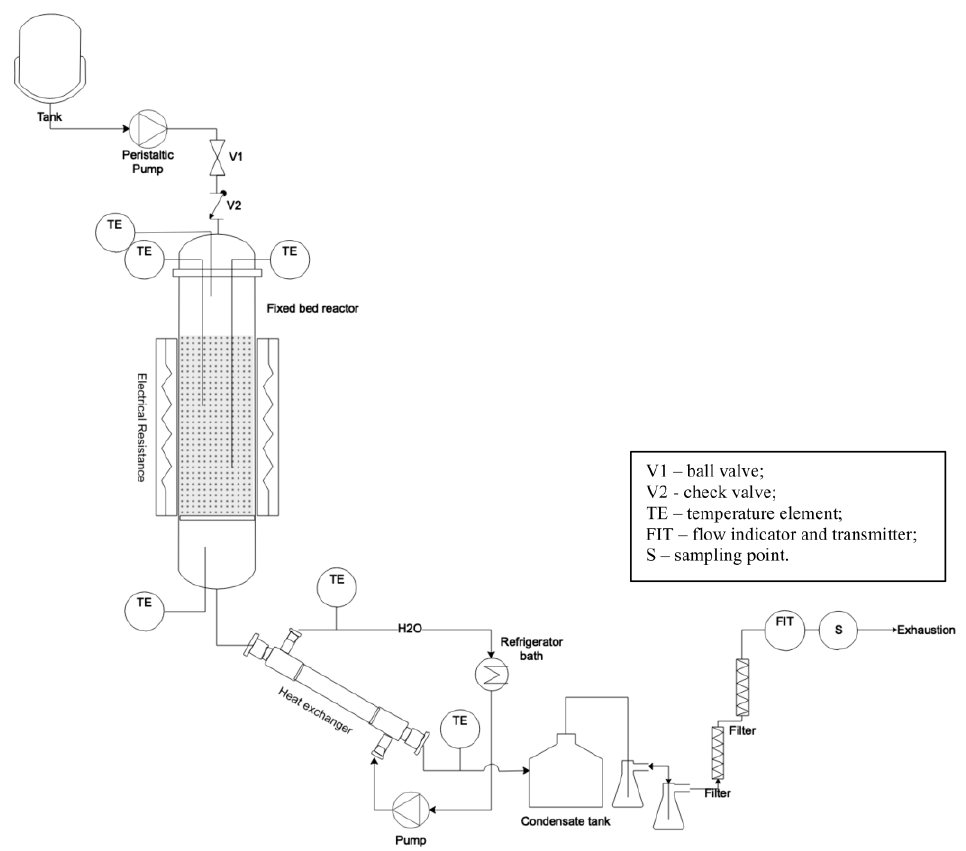
Figure 1. Schematic diagram of the gasification experimental apparatus.